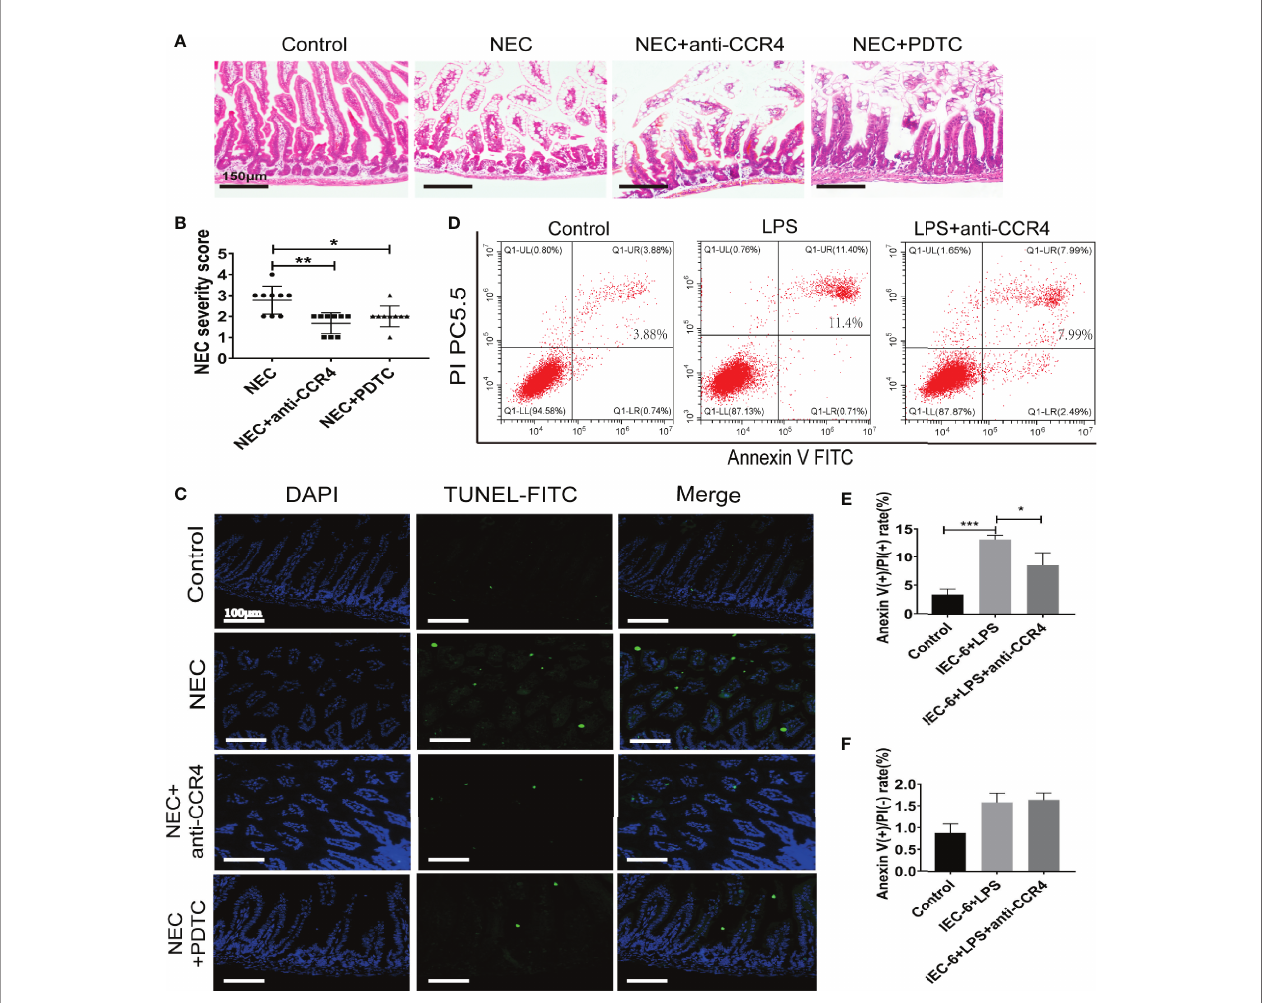
FIGURE 5 | CCL3 mediates intestinal injury by binding to CCR4 during NEC. (A) Representative images of H&E stain from control, NEC, NEC+anti-CCR4 and NEC+PDTC groups (Scale bar =150 m m). (B) Histopathological scores in Control, NEC, NEC+anti-CCR4 and NEC+PDTC groups, as shown in (A) . *p < 0.05, **p < 0.01 when compared between groups. (Mann-Whitney U test) (C) Representative images of TUNEL (FITC) stained sections from control, NEC, NEC+anti-CCR4 and NEC+PDTC groups (Scale bar =100 m m). (D-F) FCM was performed to evaluate the effects of anti-CCR4 on the apoptosis of IEC-6 cells. Anexin (+) PI (-) represents early apoptosis and Anexin (+) PI (+) represents late apoptosis. Data are expressed as mean ± SD.*p < 0.05 ***p < 0.001 versus control or treatment groups. (Mann- Whitney U